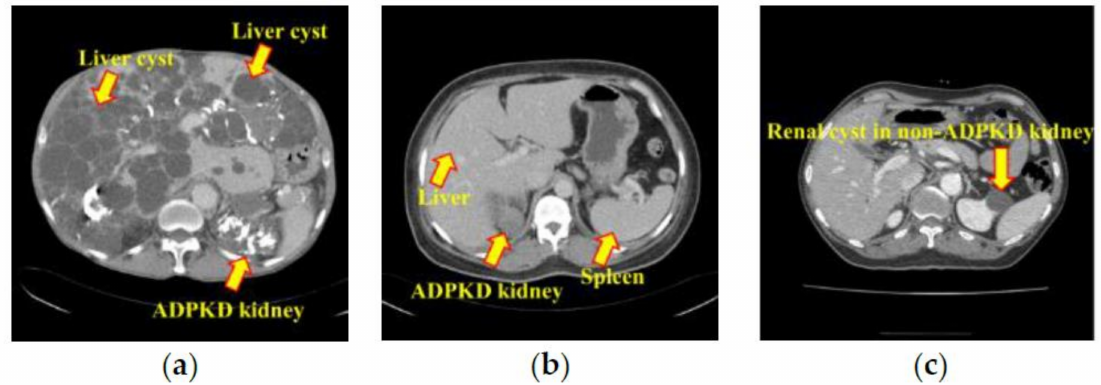
Figure 1. Kidney with di ff erent types of cysts: ( a ) Autosomal Dominant Polycystic Kidney Disease (ADPKD) kidney and liver cyst; ( b ) ADPKD kidney, liver, and spleen; ( c ) Renal cyst in